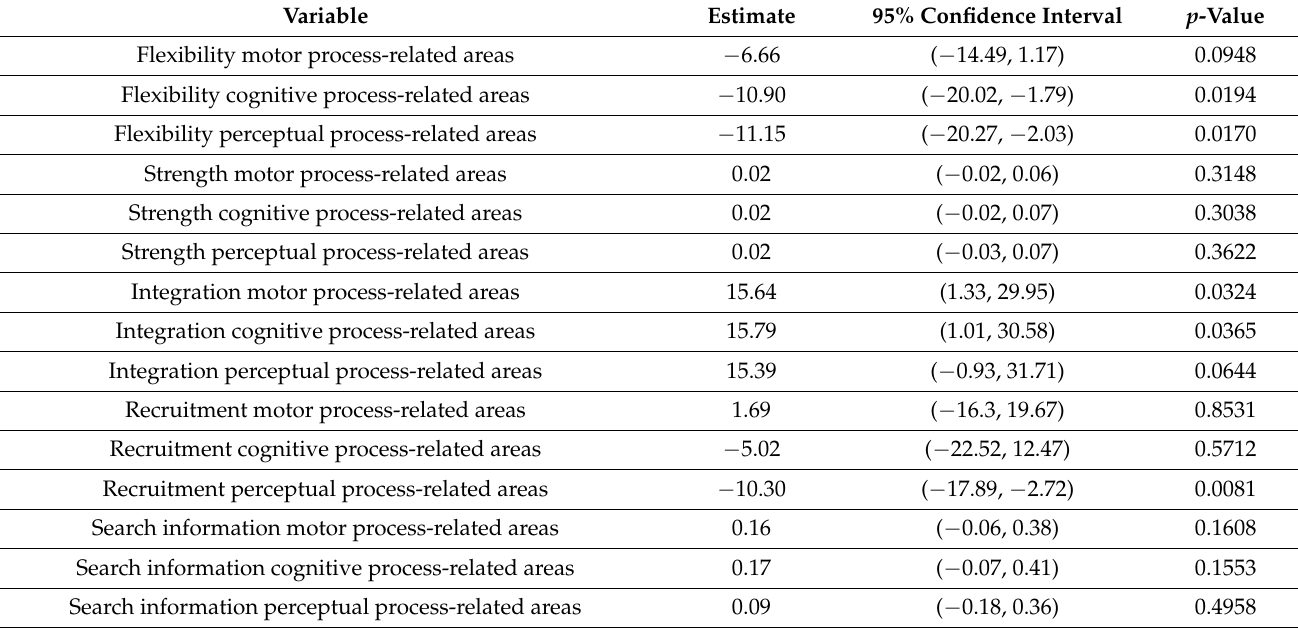
Table 4. Results of univariate analysis, representing the relationship between distraction level and EEG features.